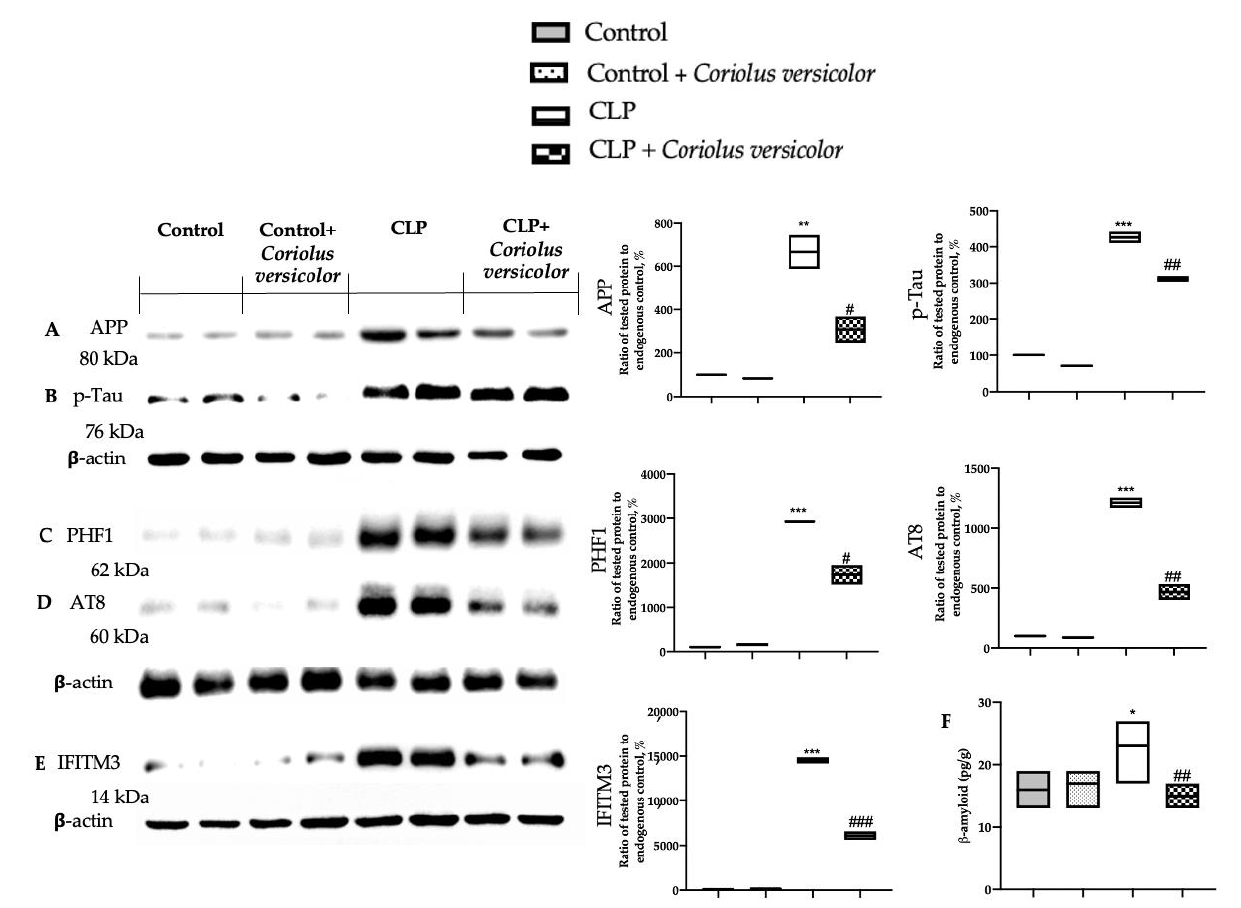
Figure 13. Coriolus versicolor reduced AD-like neuropathology induced by CLP 28 days after surgery. Western blot analysis of amyloid precursor protein (APP) ( A ), phosphorylated-Tau (p-Tau) ( B ), pathologically phosphorylated tau (PHF1) ( C ), phosphorylated tau (Ser202 and Thr205) (AT8) ( D ), and interferon-induced transmembrane protein 3 (IFITM3) ( E ) expression; β -amyloid levels ( F ). * p < 0.05 vs. control, # p < 0.05 vs. CLP, ** p < 0.01 vs. control, ## p < 0.01 vs. CLP, *** p < 0.001 vs. control, ### p < 0.001 vs. CLP.